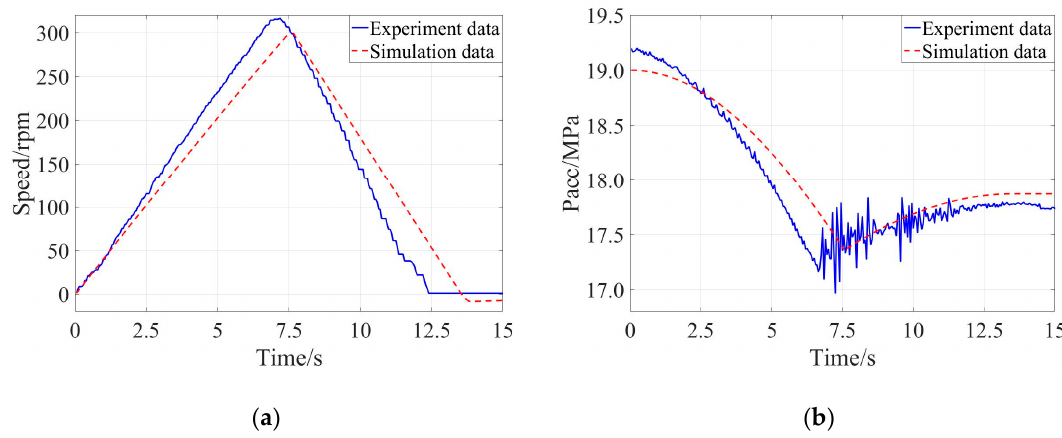
Figure 13. Comparison of the experimental result and simulation result when the braking intensity was 0.50: ( a ) Evolution of speed of the flywheel, ( b ) Evolution of pressure of the accumulator.